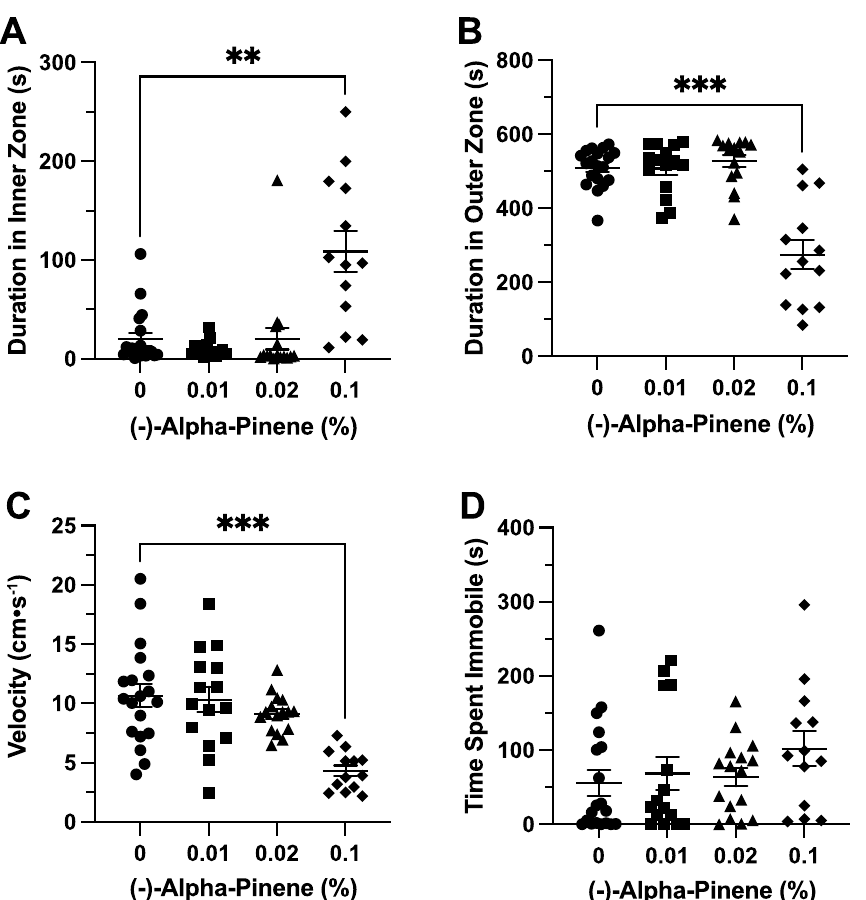
Figure 4. The effects of (−)-alpha-pinene administration in the open field test. Average duration of time fish spent in the ( A ) inner and ( B ) outer ‘thigmotaxis’ zone during the open field test. Fish locomotion was quantified in the open field test by measuring ( C ) swimming velocity and ( D ) time spent immobile. All data are presented as mean ± S.E.M. Significant differences between controls and (−)-alpha-pinene treated groups are indicated by **( p < 0.01) and ***( p <